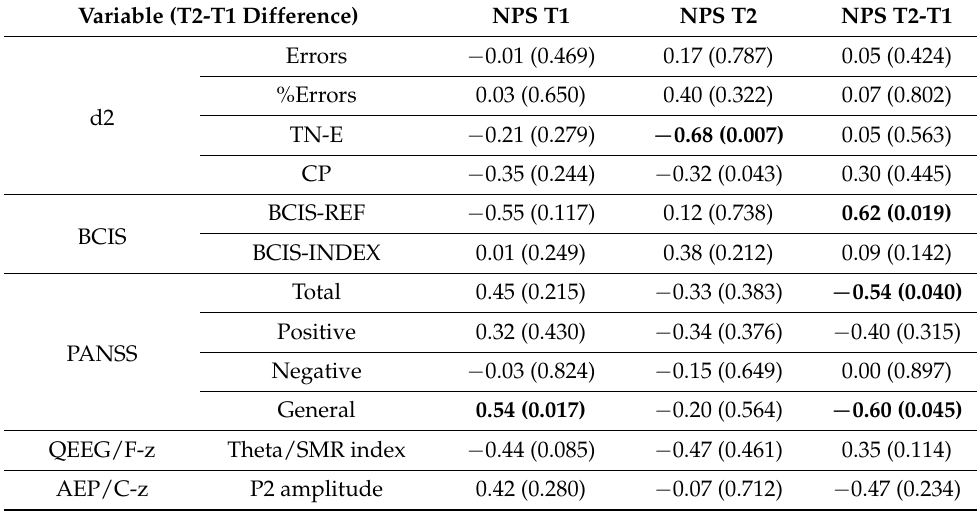
Table 4. The Pearson’s r product–moment correlation coefficients: NPS T1, NPS T2, and NPS T2-T1 correlated with neurocognitive and physiological variables (T2-T1). Only strong correlations for absolute values of r > 0.5 ( p < 0.05) were bolded. p -values in parentheses. Variable (T2-T1 Difference) NPS